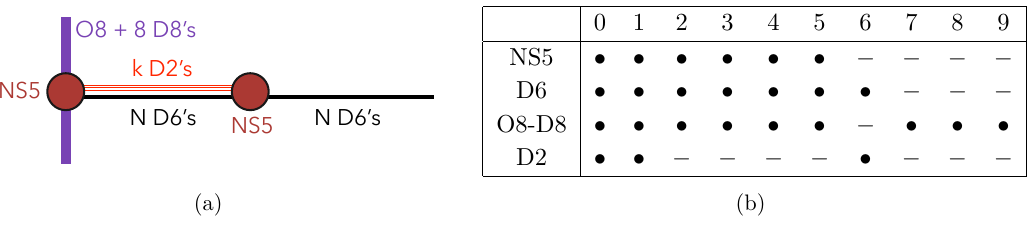
Figure 3. IIA brane system for 6d SU( N ) theory Higgsable to E-string